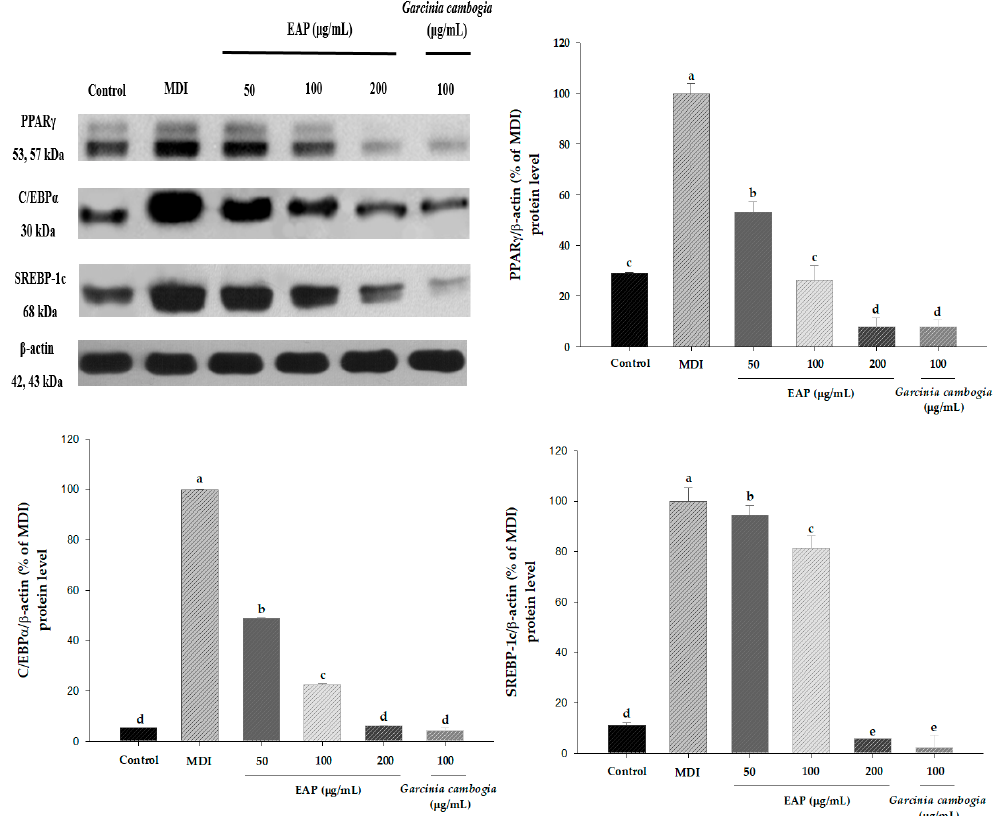
Figure 5. E ff ects of EAP on protein levels of PPAR γ , C / EBP α and SREBP-1c in 3T3-L1 adipocytes. EAP: Erigeron annuus (L.) Pers. water extract. These cells were treated with EAP (from 50 to 200 µ g / mL) for seven days during di ff erentiation. (a) Western blot analysis of PPAR γ , C / EBP α , and SREBP-1c. At day seven, total protein was harvested. (b–d) Protein levels were determined by western blotting. Values are presented as mean ± standard deviation. Di ff erences between means were considered statistically significant at p < 0.05.